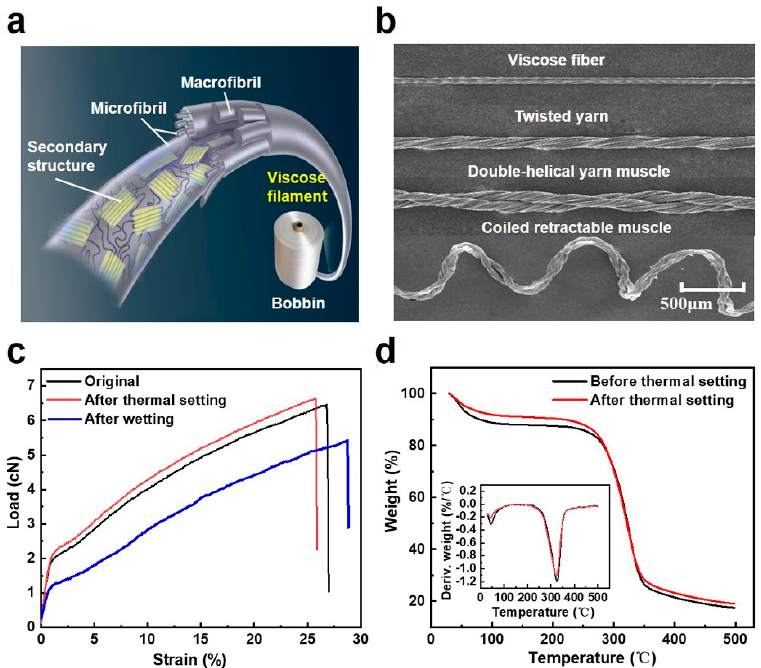
Figure 1. The structure and performance of viscose filaments. ( a ) Hierarchical structure of a viscose filament. ( b ) The SEM image of viscose filaments in different morphological states. ( c ) Typical tensile curves of a non-twist single viscose filament with different treatment states. ( d ) TGA curves of viscose filaments before and after thermal setting.